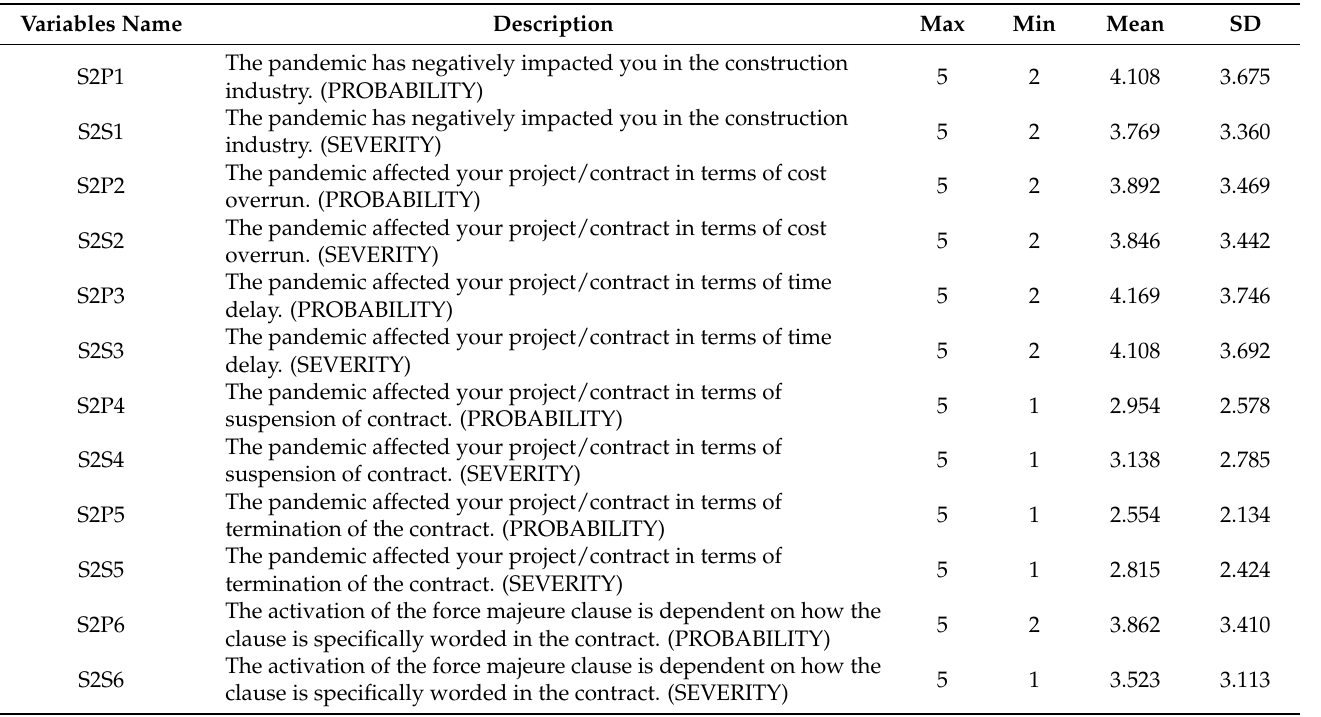
Table 2. Basic statistics of the